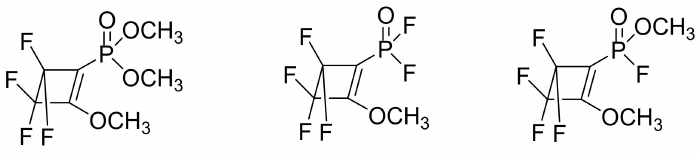
Figure 2. The unexpected products derived upon decomposition of 1